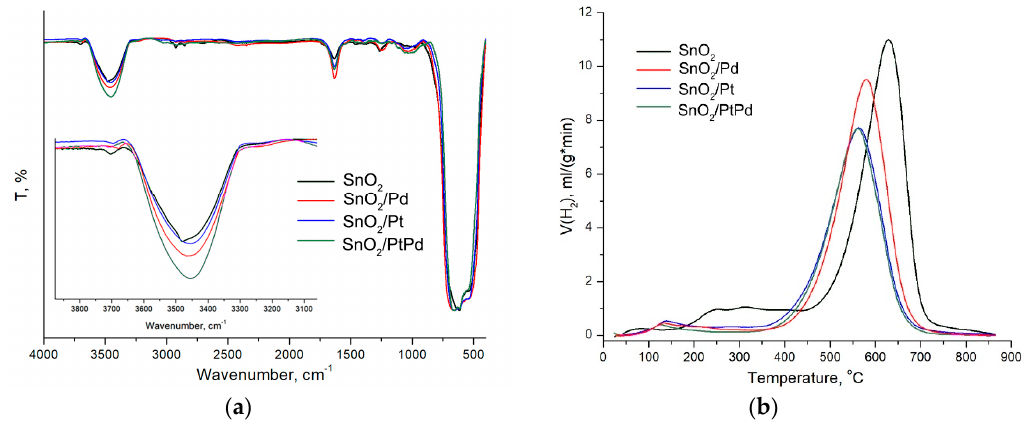
Figure 9. ( a ) IR spectra of blank SnO 2 and nanocomposites normalized to the intensity Sn-O oscillations. Inset: enlarged spectra in 3100–3800 cm − 1 region. ( b ) TPR-H 2 profiles of blank SnO 2 and nanocomposites.